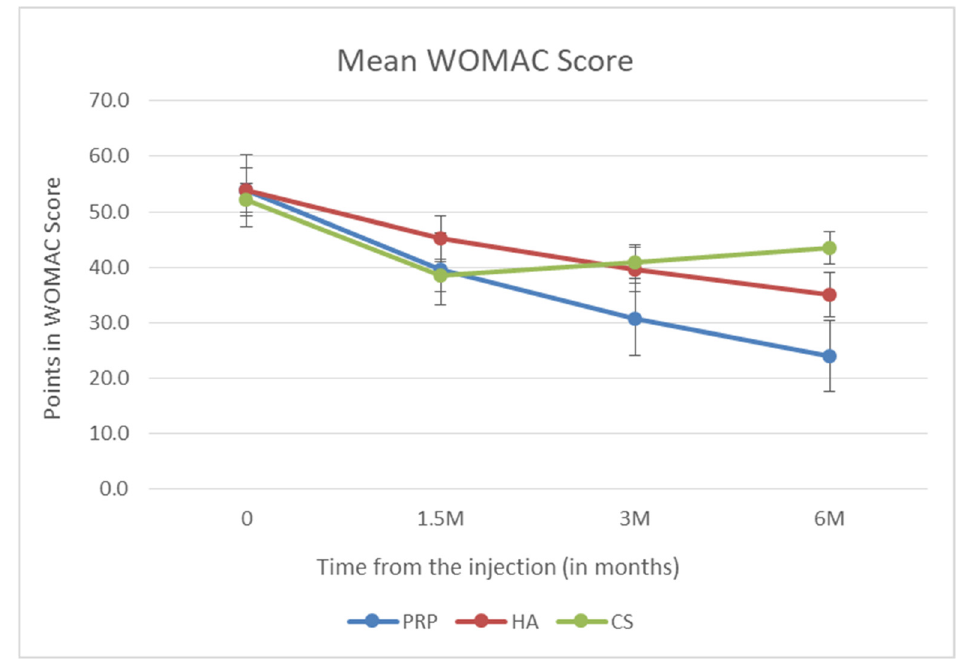
Figure 5. Mean WOMAC value.